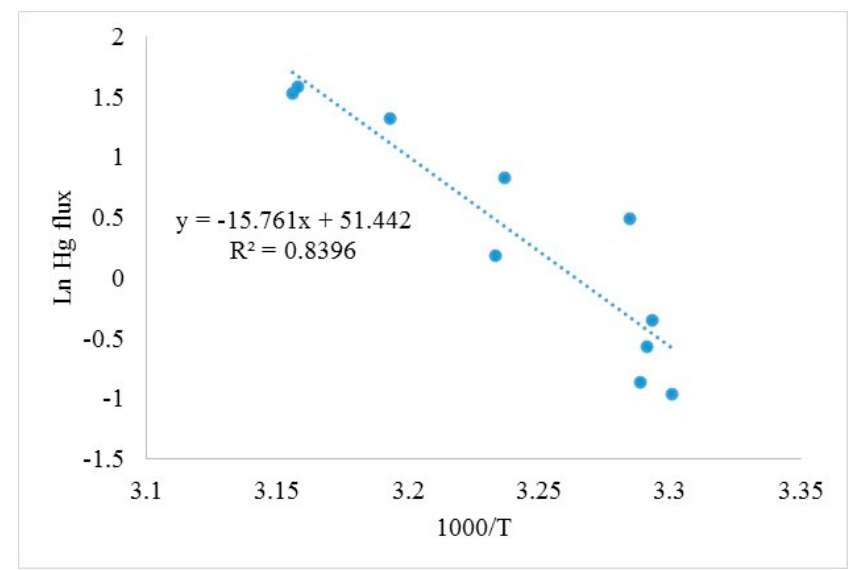
Figure 6. Arrhenius relationship between GEM flux and soil temperature over a loblolly pine forest floor in Mississippi during the summer.